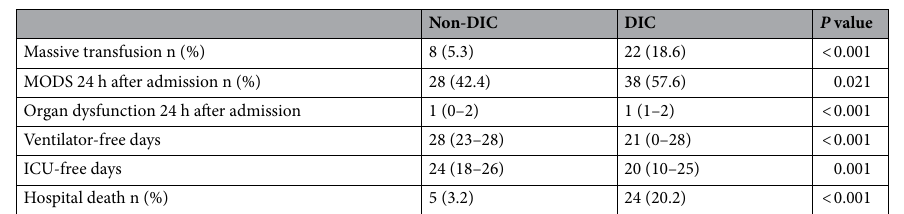
Table 2. Outcomes of the patients. Values are expressed as the median with the 25th–75th interquartile range or number (percentage). DIC disseminated intravascular coagulation, ICU intensive care unit, MODS multiple organ dysfunction syndrome. Missing data from upper to bottom, 5, 95, 95, 8, 35, 3, respectively.